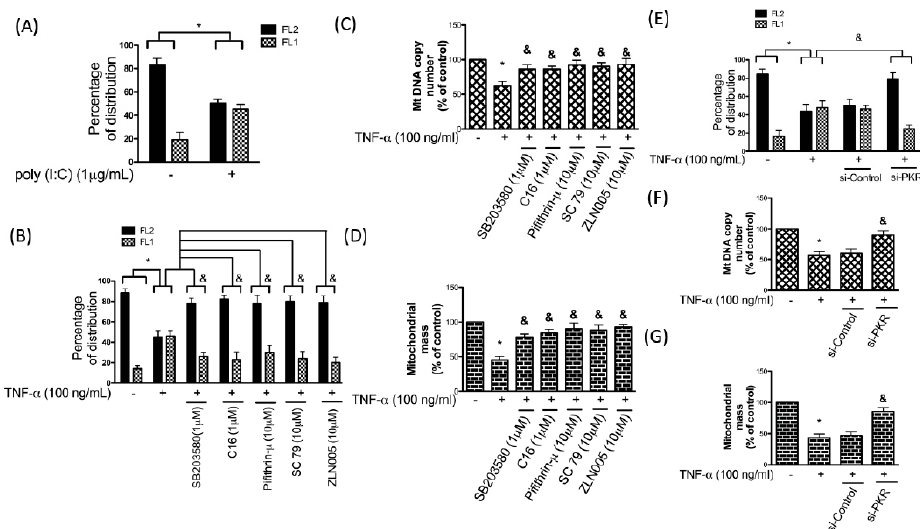
Figure 5. Percentage of cells expressing JC-1 aggregates (red fluorescence; FL2) and JC-1 monomers (green fluorescence; FL1) were assessed using flow cytometry with or without poly I:C treatment. ( A , B ) Percentage of cells expressing FL2 and FL1, ( C ) mitochondrial DNA copy number, and ( D ) mitochondrial mass were examined after administration of TNF- α with p38 inhibitor SB203580, PKR inhibitor C16, p53 inhibitor Pifithrin- µ , AKT activator SC79, or PGC-1 α stimulator ZLN005. ( E ) Percentage of cells expressing FL2 and FL1, ( F ) mitochondrial DNA copy number, and ( G ) mitochondrial mass were evaluated in TNF- α -stimulated chondrocytes in the presence of small-interfering (si)-PKR or si-Control. n = 3; * p < 0.05 compared to control group. p < 0.05 compared to TNF- α group, p values were generated by ANOVA using the Tukey’s